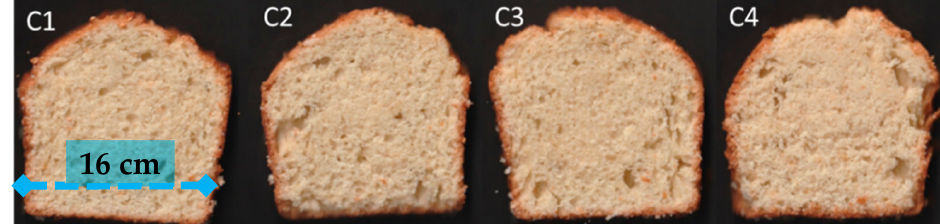
Figure 4. Slices of the cakes made with different fats. C1, C2, and C3 contained fats E1 (35% CA and 65% CO), E2 (30% CA and 70% CO), and E3 (25% CA and 75% CO), respectively, and control (C4) contained palm oil.